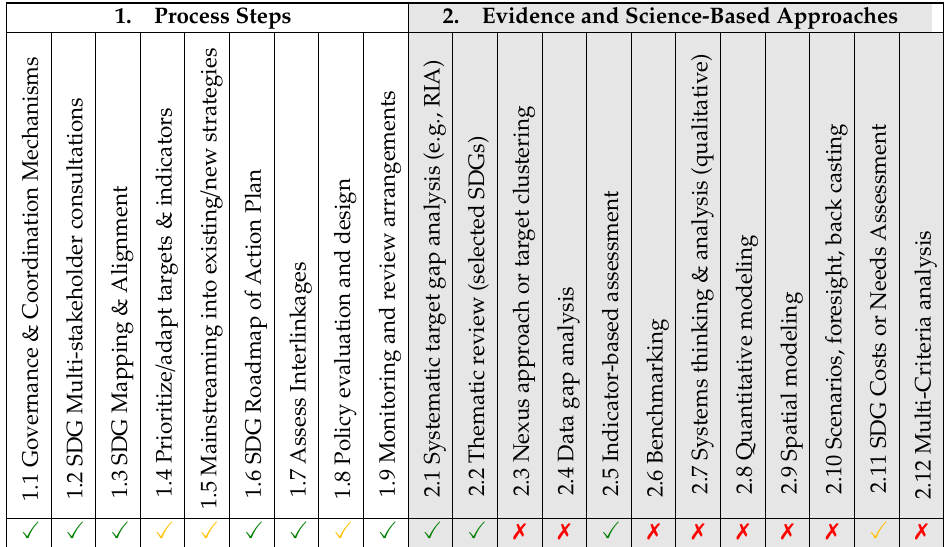
Table 2. Overview of Process steps and evidence- and science-based approaches to support Sustainable Development Group (SDG) implementation in